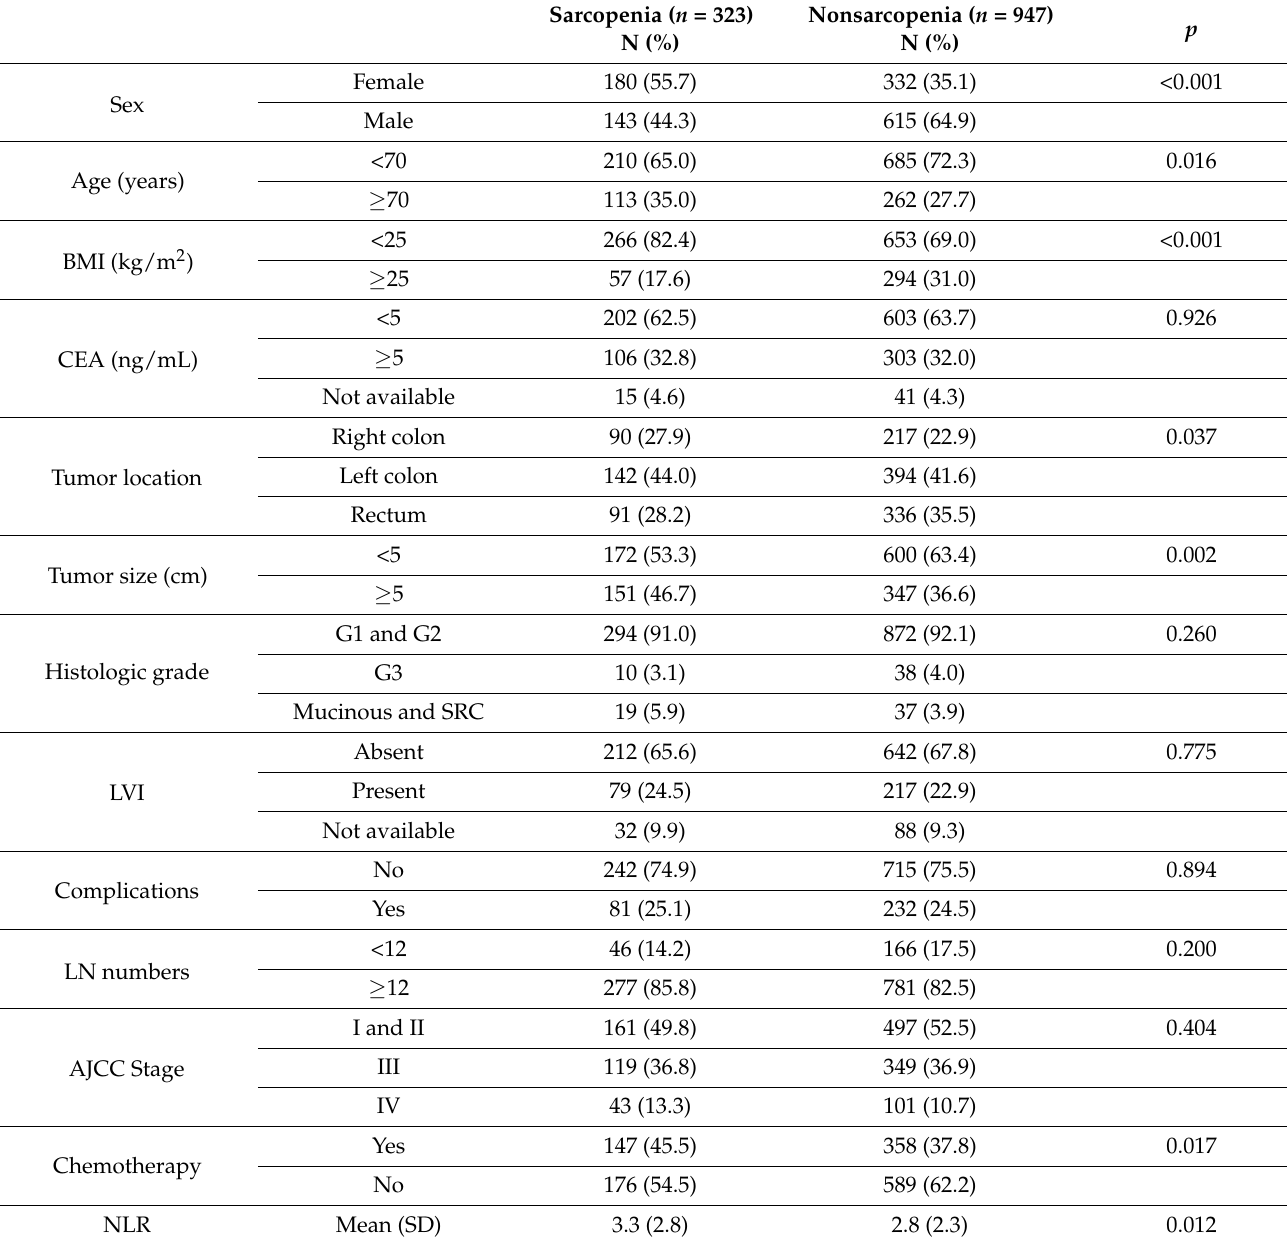
Table 1. Patient characteristics according to sarcopenia defined by Martin ( n =